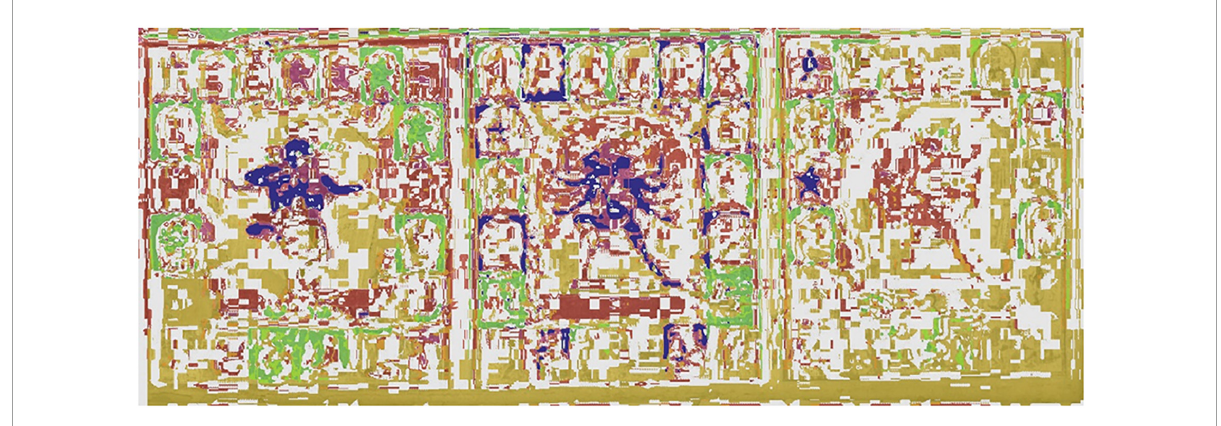
FIGURE8 Image masks; the masks for each area are shown in the figure as solid